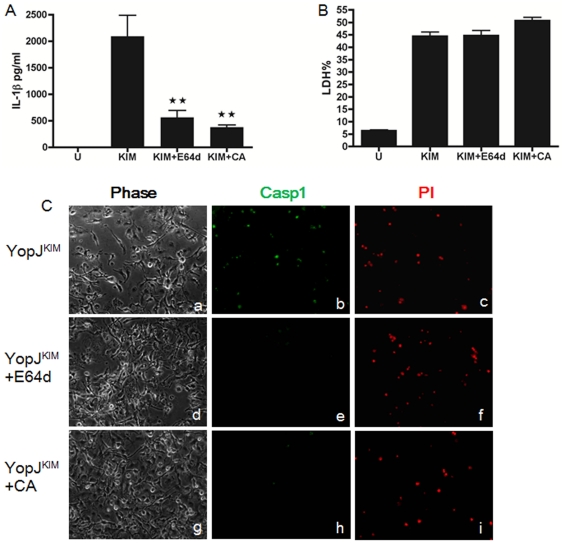
Inhibitors of cathepsin B reduce caspase-1 activation in macrophages infected with KIM5.BMDMs were left untreated or treated with 25 µM of E64d or CA-074 Me (CA) for 1 hr. Following infection with Y. pestis strains expressing YopJKIM in the absence or presence of the inhibitors, supernatants were collected (A, B) or microscopic assay was performed (C). IL-1β ELISA (A) and LDH release assay (B) was done on supernatants collected 24 hr post-infection. Results shown are the averages from three independent experiments. Error bars represent standard deviations. (★★, P<0.01 as determined by one way ANOVA as compared to infection in absence of inhibitor) (C) Infected BMDMs on coverslips were incubated with FAM-YVAD-FAM 9 hr post-infection stained for active caspase-1 (green) for 1 hr and PI uptake (red) immediately before observation. Representative images of phase, green and red signals were captured by digital photomicroscopy.